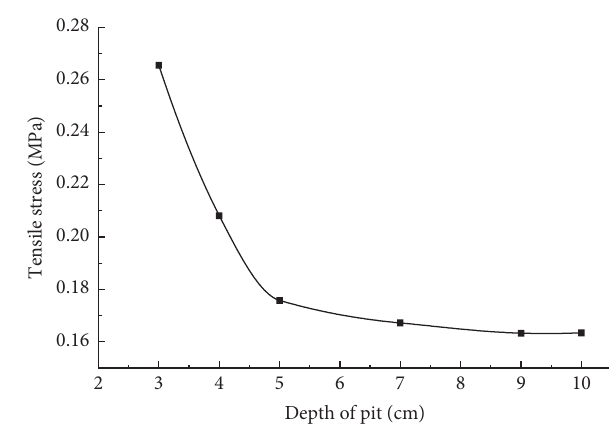
Figure 16: The effect of depth of pit on tensile stress of patch